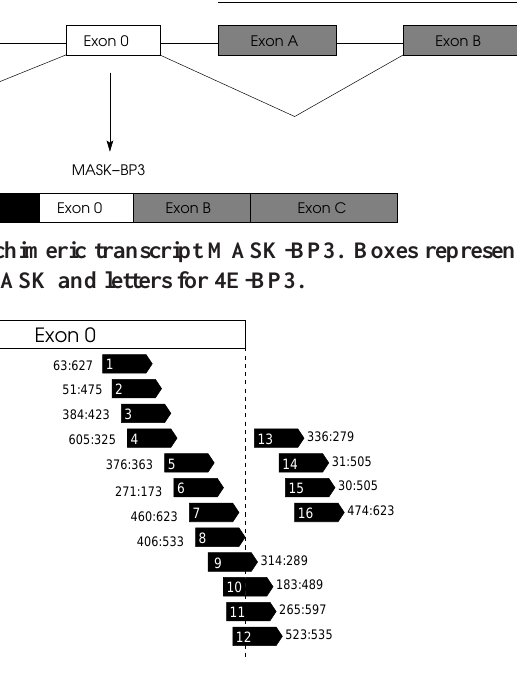
Figure 4: Schematic diagram showing probe positions of set 67520 at in relation to exon 0 of MASK-BP3.